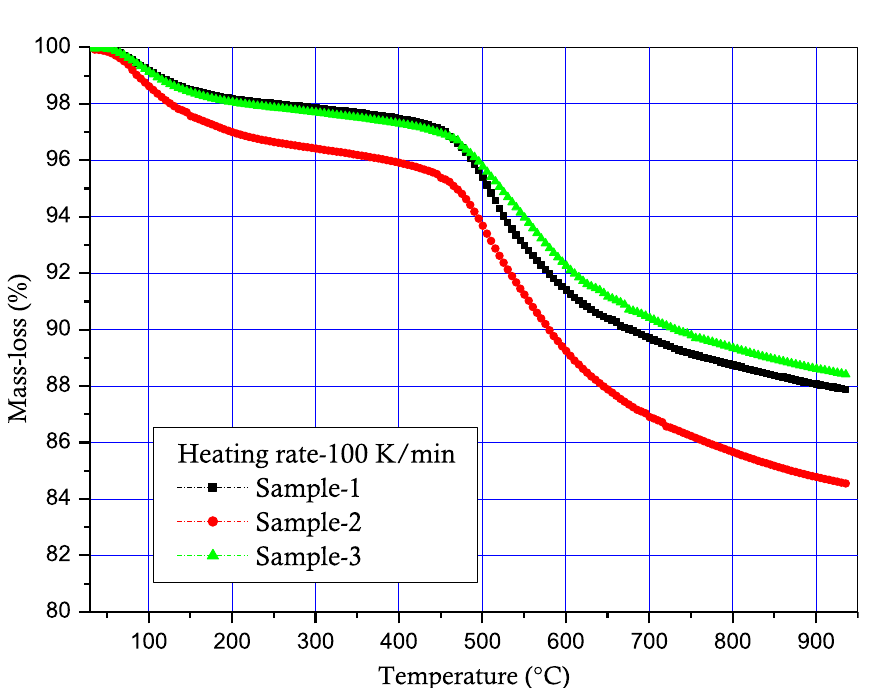
Fig. 1 TG curves for low rank coal at heating rate 50 K/min